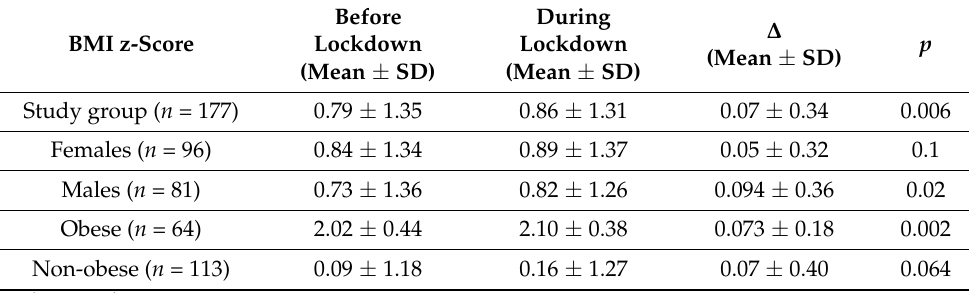
Table 3. Changes in BMI z-score before and after the lockdown.